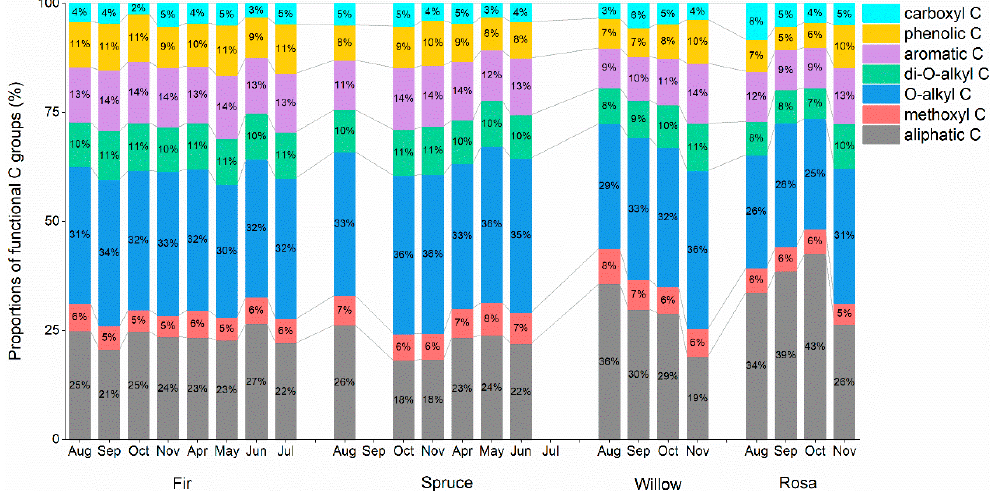
Figure 2. Monthly dynamics of the proportions of functional C fractions (%) (aliphatic C, methoxyl C, O-alkyl C, di-O-alkyl C, aromatic C, phenolic C, and carboxyl C) in newly shed foliar litter obtained from the integration of different chemical shifts determined via CP/MAS 13 C NMR